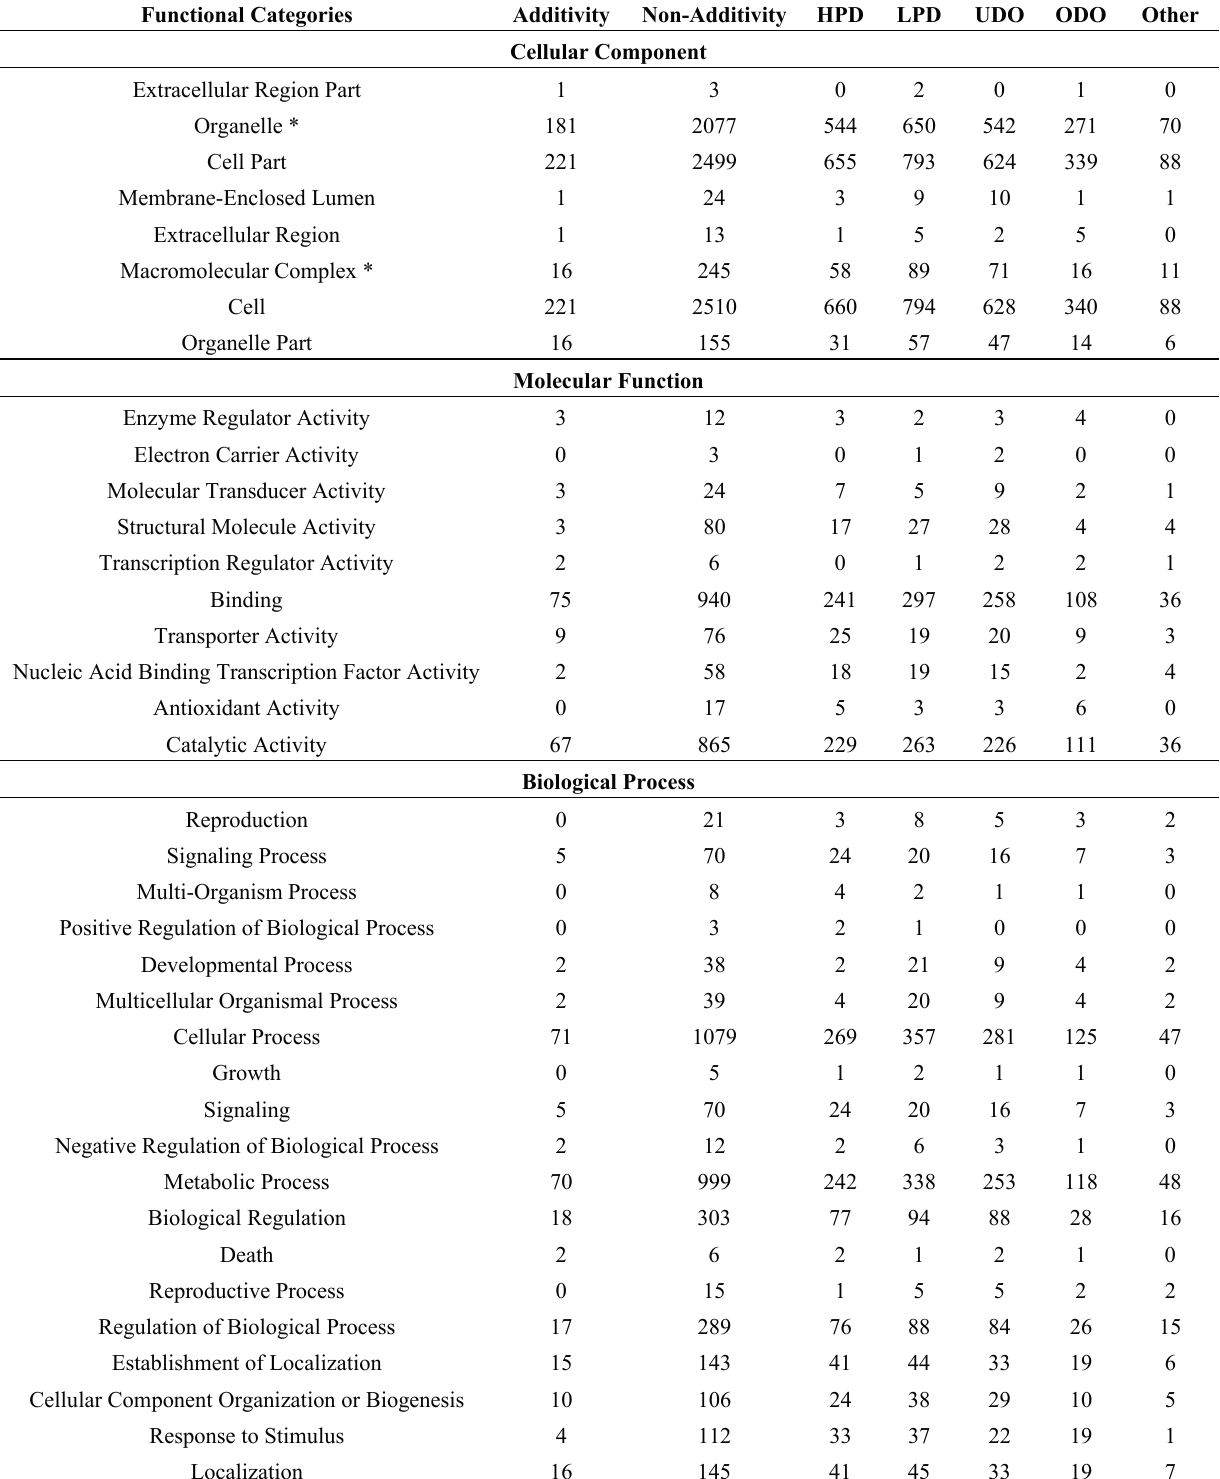
Table 3. Functional classification of different genes between inbred parents or between parental lines and their F hybrid. * indicated the significant enrichment in 1 functional